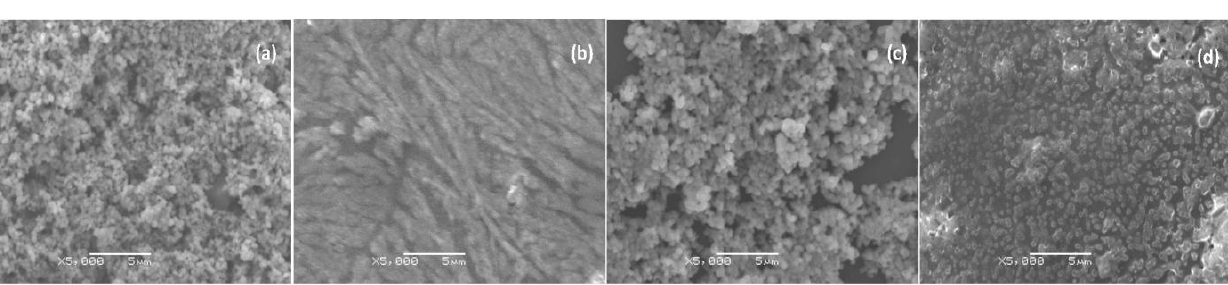
O -; ( b ) DNA/chitosan-; 3 4 O /horseradish peroxidase 3 4